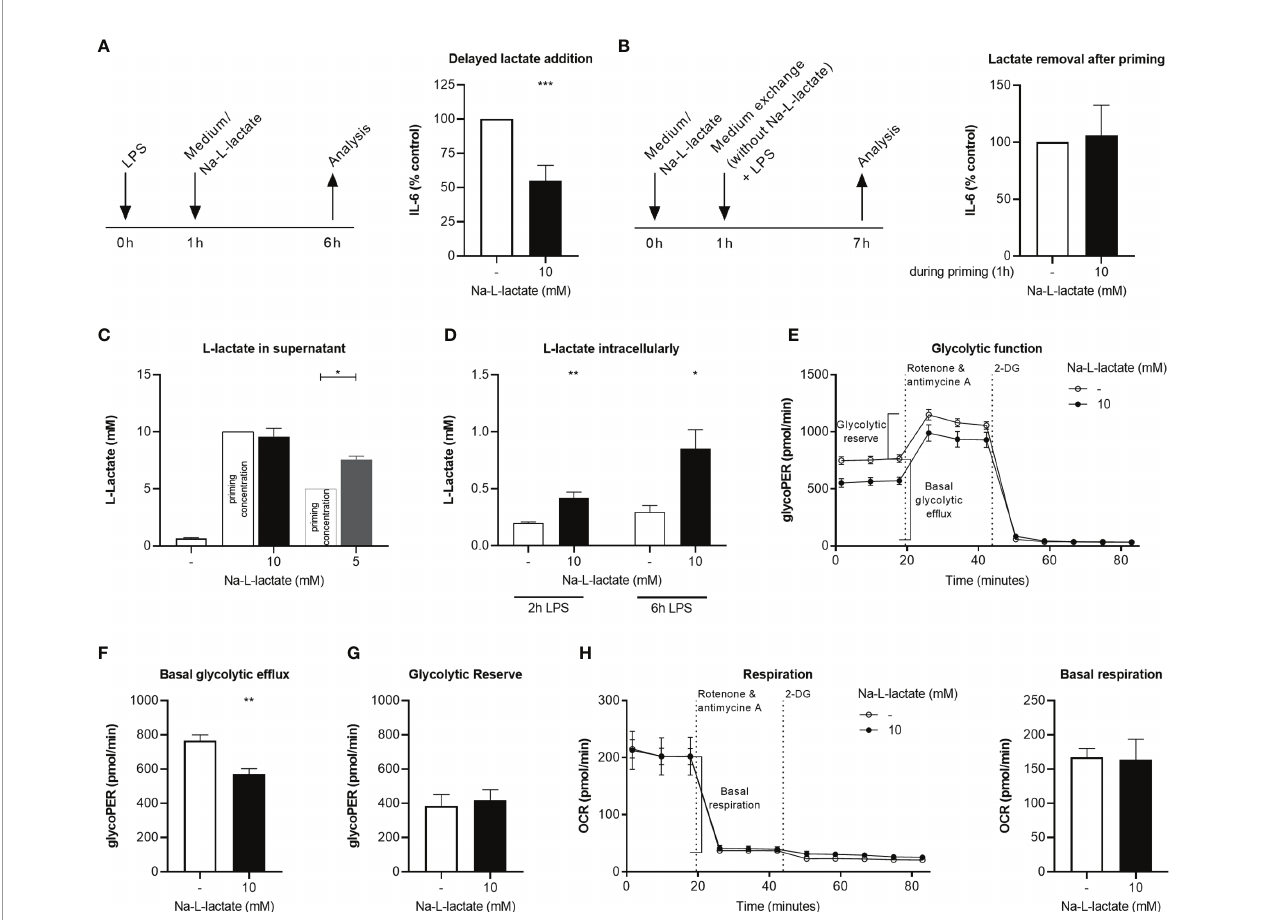
FIGURE 2 | Intracellular lactate accumulation hinders glycolytic fl ux. (A) IL-6 secretion from MM6 after six hours stimulation with LPS and addition of Na-L-lactate on hour after the start of stimulation. (B) IL-6 secretion after one-hour priming with 10mM Na-L-lactate which was removed prior to a six-hour stimulation with LPS. L- lactate concentration in (C) the supernatant or (D) intracellularly after one-hour priming with Na-L-lactate at the indicated concentration and two- or six-hours stimulation with LPS. (E) Calculation of the glycolytic indices (F) basal glycolytic ef fl ux and (G) glycolytic reserve after one-hour priming with 10mM Na-L-lactate and six hours stimulation with LPS. (H) Calculation of basal respiration one-hour priming with 10mM Na-L-lactate and six hours stimulation with LPS. Data are shown as (A, B) mean + SD or (C, H) mean + SEM (n=5; except for (C) n=3). Group comparisons were performed by unpaired t test, except for (A, C), where one sample t tests were performed against the theoretical value 100, 10, or 5 respectively (*** P ≤ 0.001, ** P ≤ 0.01, * P ≤